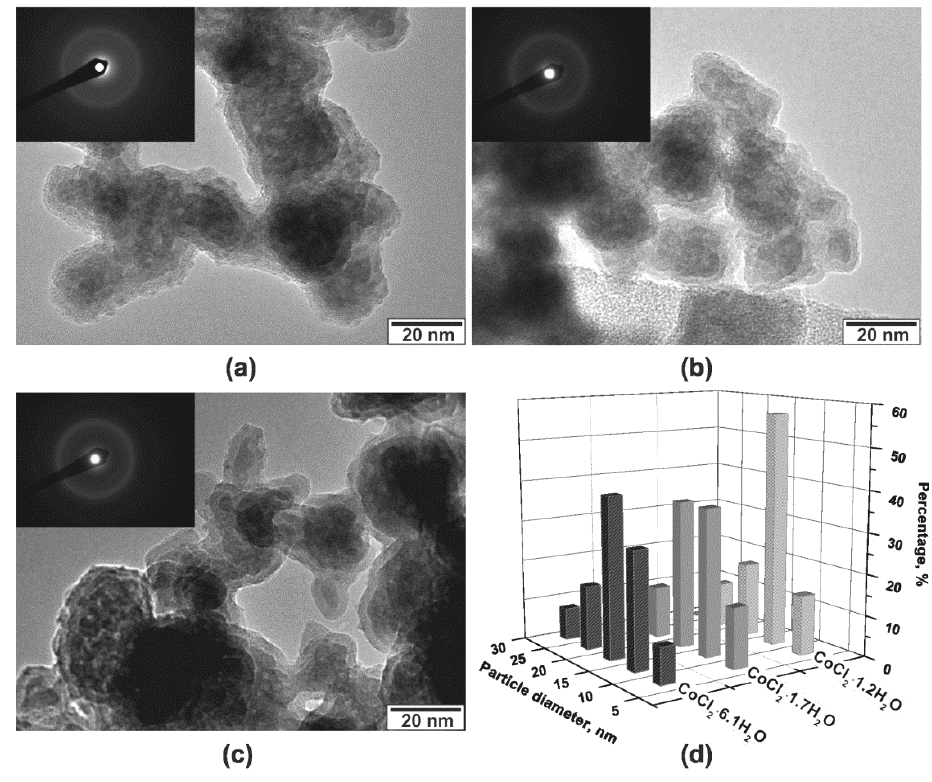
Figure 6. TEM images of cobalt catalysts forming from ( a ) CoCl 2 · 6.1H 2 O, ( b ) CoCl 2 · 1.7H 2 O and ( c ) CoCl 2 · 1.2H 2 O, and ( d ) their particle size distribution. Table 3. Characteristics of reduced catalysts after sodium borohydride